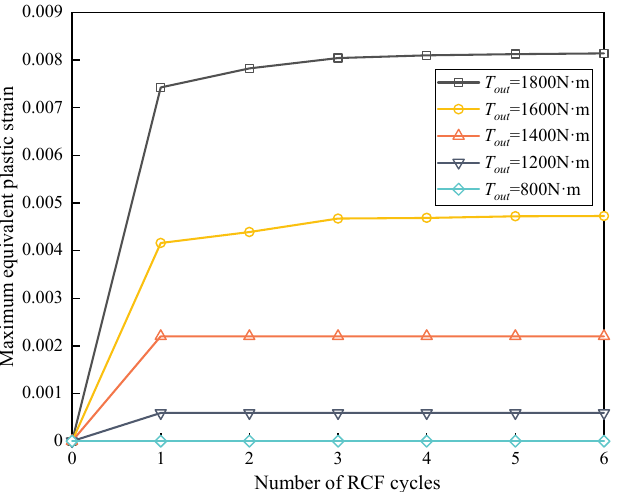
Figure 20. Effect of output torque on the maximum equivalent plastic strain (Max PEEQ). Figure 21 demonstrates the variation of the maximum equivalent plastic strain (Max PEEQ) corresponding to different residual stress cases in the RCF cycles when the output torque is set as T out = 1800 N · m and the maximum contact stress P h = 2.34 GPa. Compared with the case without IRS, ICRS reduces PEEQ by 6.3%, while ITRS increases PEEQ by 37.5%. The increase rate of PEEQ for ITRS is obviously greater than the decrease rate of PEEQ for ICRS. RCF behaviors such as pitting and spalling more likely appear near the surface owing to the position of Max PEEQ near to the contact surface with